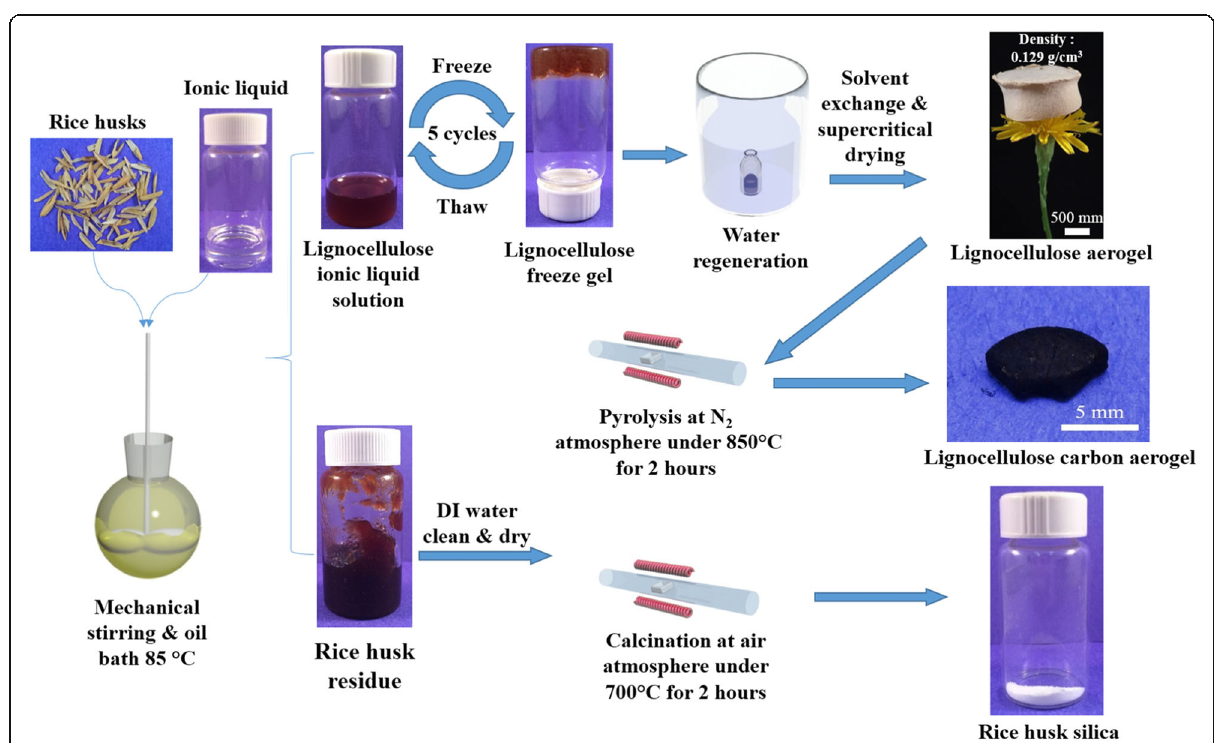
Fig. 1 Flow chart of the process to prepare LC aerogel, carbon aerogel, and RH silica